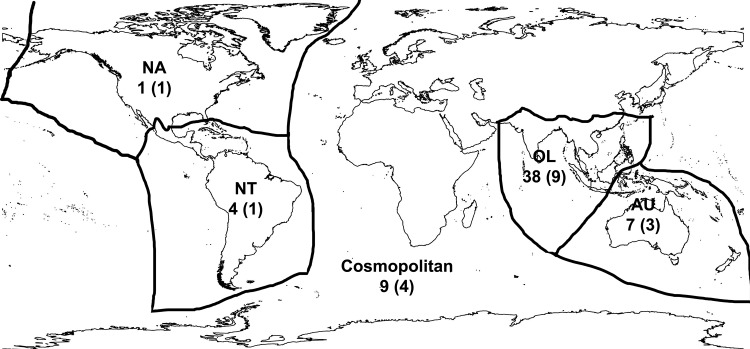
Native distribution of freshwater mollusc species in the ornamental pet trade.Numbers indicate the number of species from each zoogeographic region; numbers in brackets are the number of families. Zoogeographic regions follow [24].